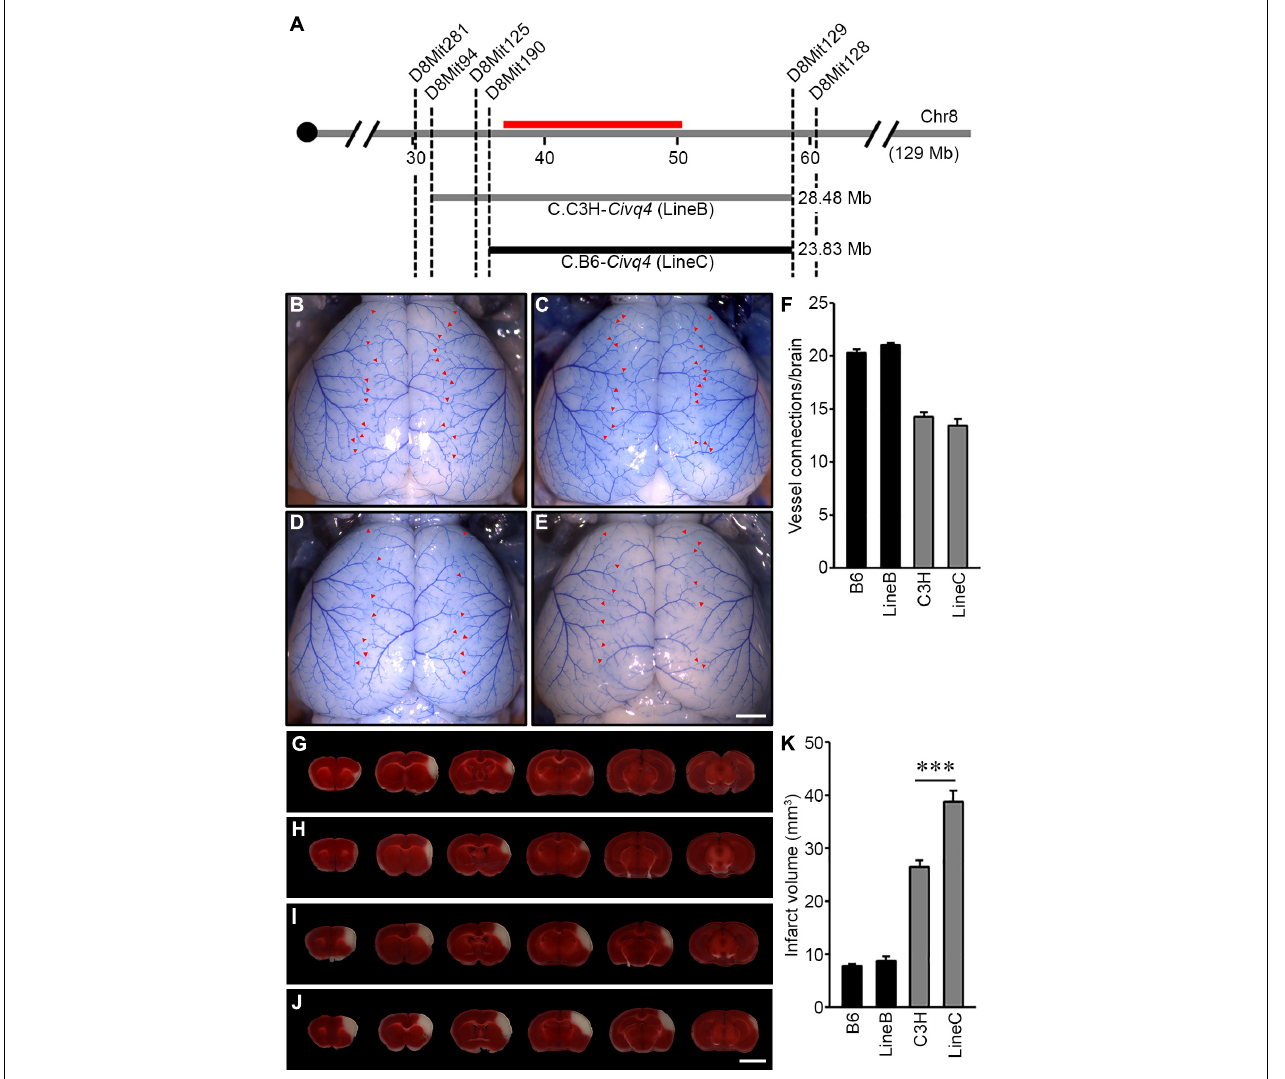
FIGURE 4 | Validation of the location and allelic effects of the locus on Chromosome 8 in congenic animals. (A) Schematic of the previously mapped Civq4 interval using reciprocal congenic mouse lines carrying either a segment of C3H Chr 8 introgressed into the B6 background [B6.C3H- Civq4 (LineB)] or a segment of B6 Chr 8 introgressed into the C3H background [C3H.B6- Civq4 (LineC)]. The red bar indicates the 1.5-LOD support interval of QTL mapping between B6 and C3H. Together, these reciprocal congenic mouse lines cover the entire interval of the Civq4 . (B–E) Representative images of the brains for inbred mouse strains, B6 (B) and C3H (D) , and reciprocal congenic mouse lines, LineB (C) and LineC (E) . The red arrowheads indicate collateral vessel connections between the ACA and MCA. Scale bar: 1 mm. (F) The graph shows the average number of collateral vessel connections between the ACA and MCA in the brain. The total number of animals for B6, LineB, C3H, and LineC were 37, 30, 21, and 12 mice, respectively. Data represent the mean ± SEM. (G–J) Serial brain sections (1 mm) for both inbred strains, B6 (G) and C3H (I) , and the reciprocal congenic mouse lines, LineB (H) and LineC (J) , are shown. The infarct appears as white tissue after 2% TTC staining. Scale bar: 5 mm. (K) The graph indicates the infarct volume 24 h after pMCAO. The total number of animals for B6, LineB, C3H, and LineC were 34, 35, 24, and 16 mice, respectively. Data represent the mean ± SEM. Statistical analysis was performed with one-way ANOVA followed by Tukey’s multiple comparison test (*** p <